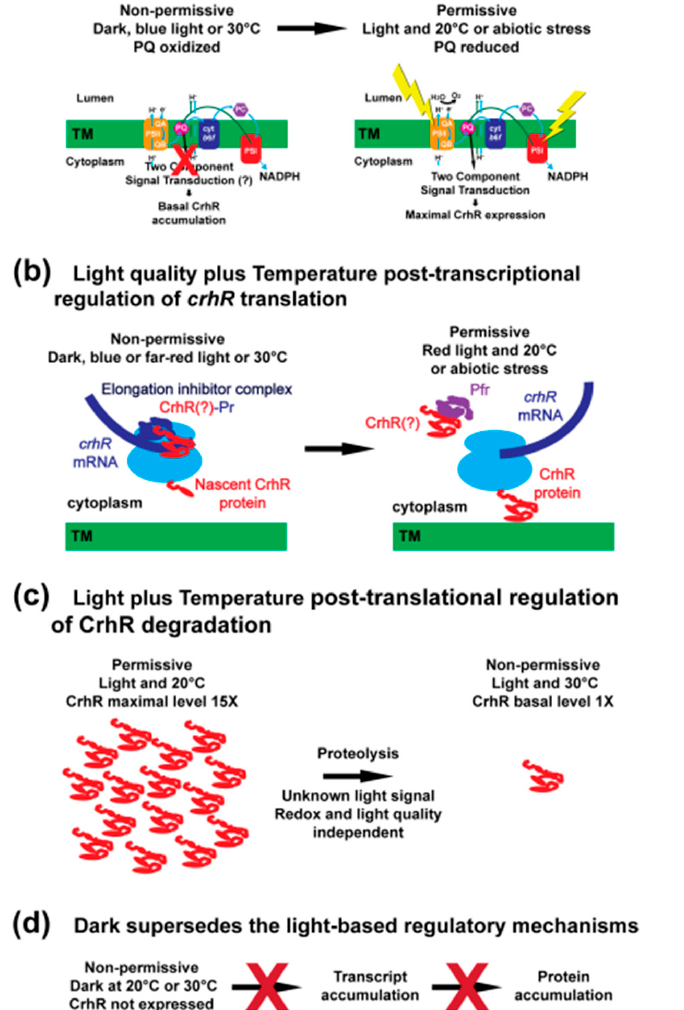
Figure 9. Summary: Discrete light signals regulate crhR expression. ( a – c ) Three discrete light signals regulate crhR expression at distinct points. ( a ) Light driven redox regulation. Under non-permissive conditions when CrhR is not required (dark, blue light, or 30 ◦ C) the relatively oxidized PQ pool does not activate a two-component signal transduction chain leading to enhanced crhR transcript accumulation. This unknown signal transduction pathway is activated by permissive conditions (light and 20 ◦ C or abiotic stress) yielding crhR expression. ( b ) Light quality regulation of CrhR accumulation. For conditions under which CrhR is not required and/or expressed (dark, blue light or 30 ◦ C) we propose that translation has initiated on crhR transcripts however elongation has halted, potentially involving binding of Pr or an unknown factor, potentially CrhR (Crh?). Transfer to permissive conditions where CrhR is expressed or required (red light and 20 ◦ C) relives the translational block allowing translation elongation and full-length CrhR production. In response to dark-light transfer, conversion of Pr-CrhR to Pfr-CrhR or binding of activated Pfr to CrhR could remove the translational block. ( c ) Light-dependent proteolysis. A redox- and light quality-independent light signal is required for induction of CrhR proteolysis in response to temperature upshift from 20 ◦ C to the non-permissive condition, 30 ◦ C. ( d ) Dark supersedes the light-based regulatory mechanisms. crhR transcript and protein are not observed to accumulate at 20 or 30 ◦ C. This indicates that darkness counteracts the low-temperature and light induction signals, reinforcing the requirement for light signals for